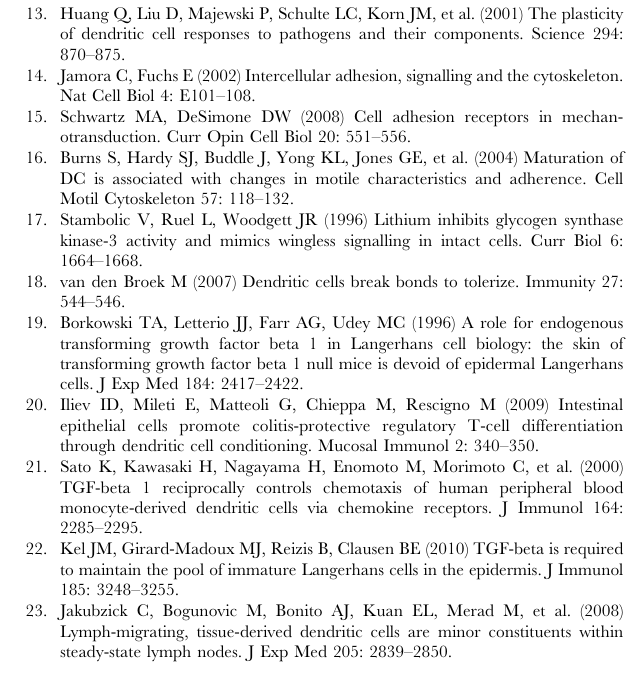
Figure S2 Integrins and DC activation. A) CD11b